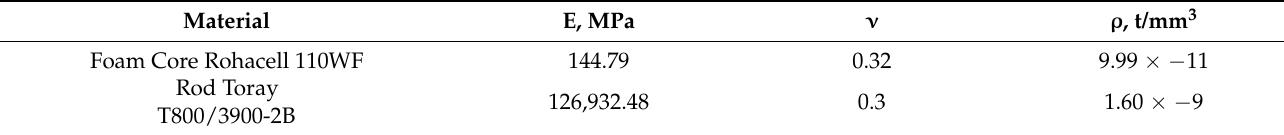
Table 2. Material properties of noncomposite components of the wing